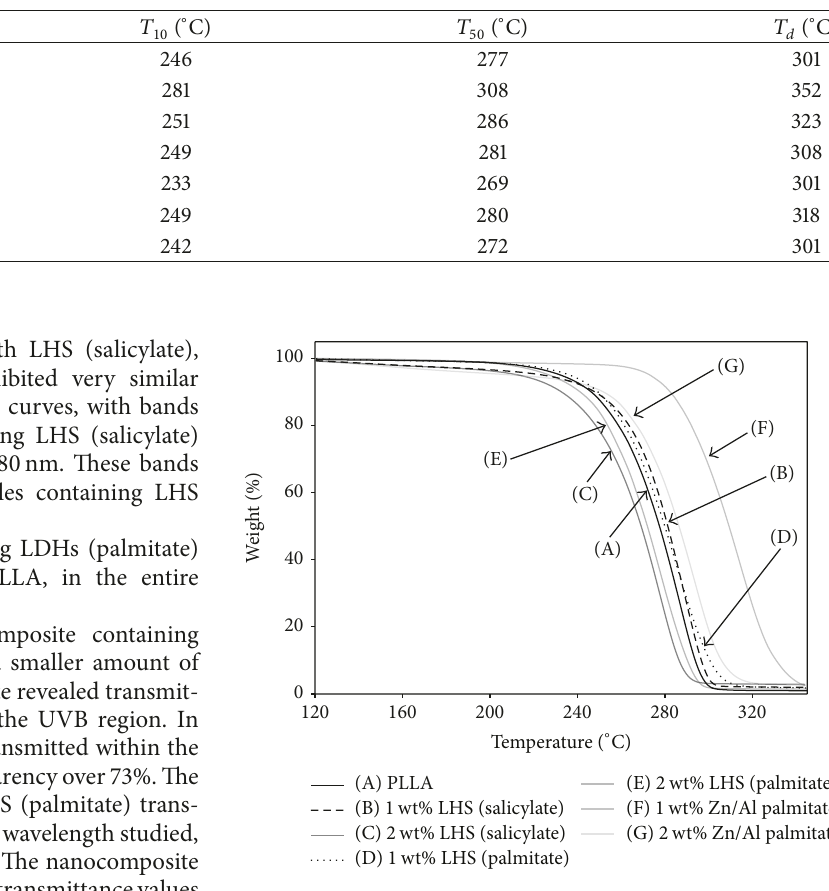
Figure 8: TGA curves to PLLA (A) and PLLA nanocomposites